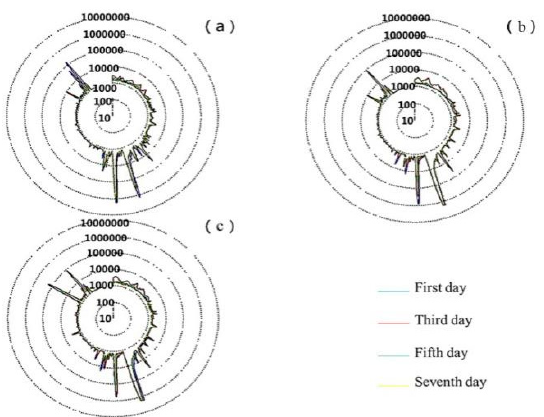
Figure 7. Radar diagrams of: ( a ) Untreated paper; ( b ) functional paper soaked in PLGA microparticles; ( c ) functional paper soaked in chitosan–PLGA microparticles.